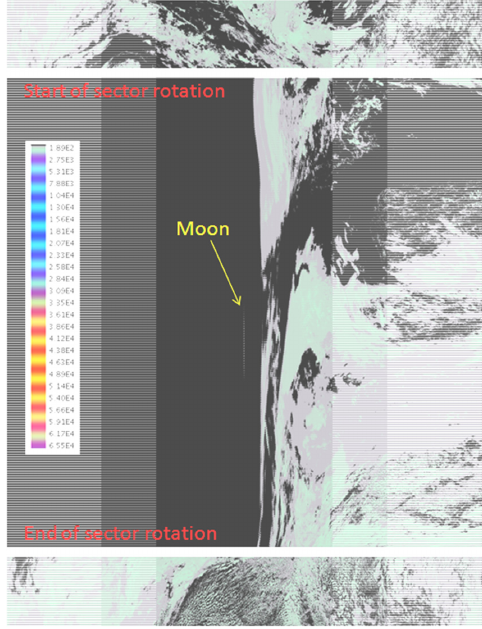
Figure 4. A scheduled lunar data collection for band M11 on 29 May 2015 with the sector